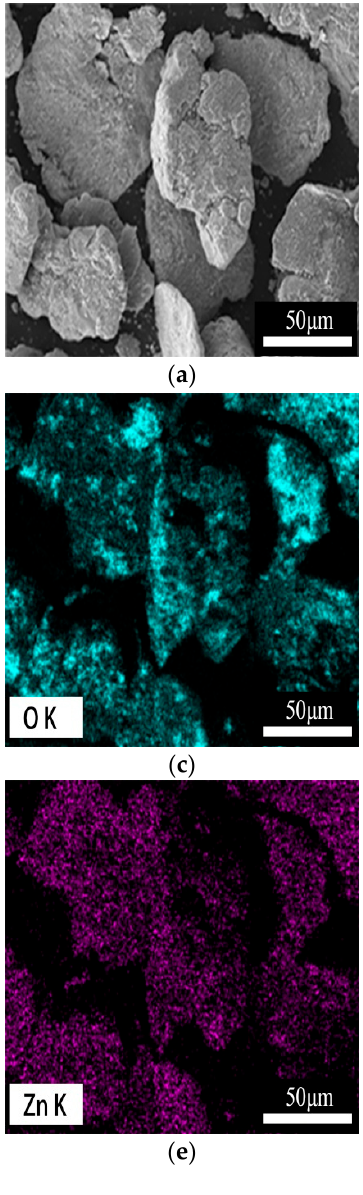
Figure 3. Cross-section SEM image of Fe 3 O 4 –MnZnFe 2 O 4 coated iron powders ( a ) and EDS mapping of Fe ( b ), O ( c ), Mn ( d ), Zn ( e ).